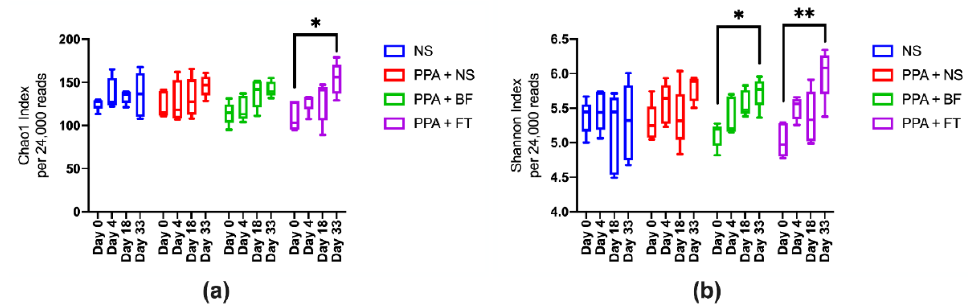
Figure 2 . Richness (Chao1) and diversity (Shannon) indices of gut microbiota along the treatment duration. ( a ) Chao1 and ( b ) and Shannon indices of gut microbiota of each treatment group was compared between the different timepoints. Total number of reads per sample was equalized to 24,000 reads. NS, normal saline group; PPA + NS, propionic acid control group; PPA + BF, Bifidobacterium treatment group; PPA + FT, fecal microbiota transplantation treatment. * p ≤ 0.05, ** p ≤ 0.001.